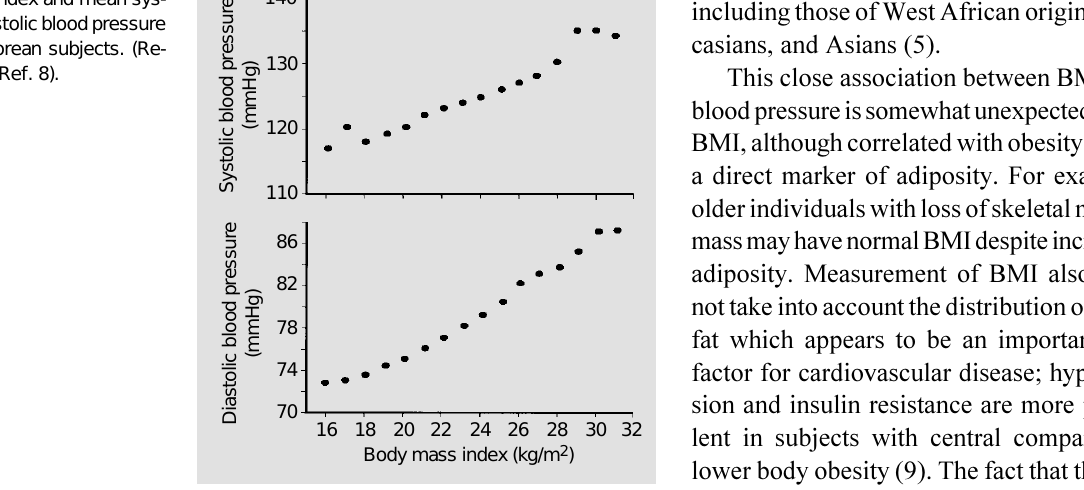
Figure 1 - Relationship between body mass index and mean sys- tolic and diastolic blood pressure in 22,354 Korean subjects. (Re- drawn from Ref.